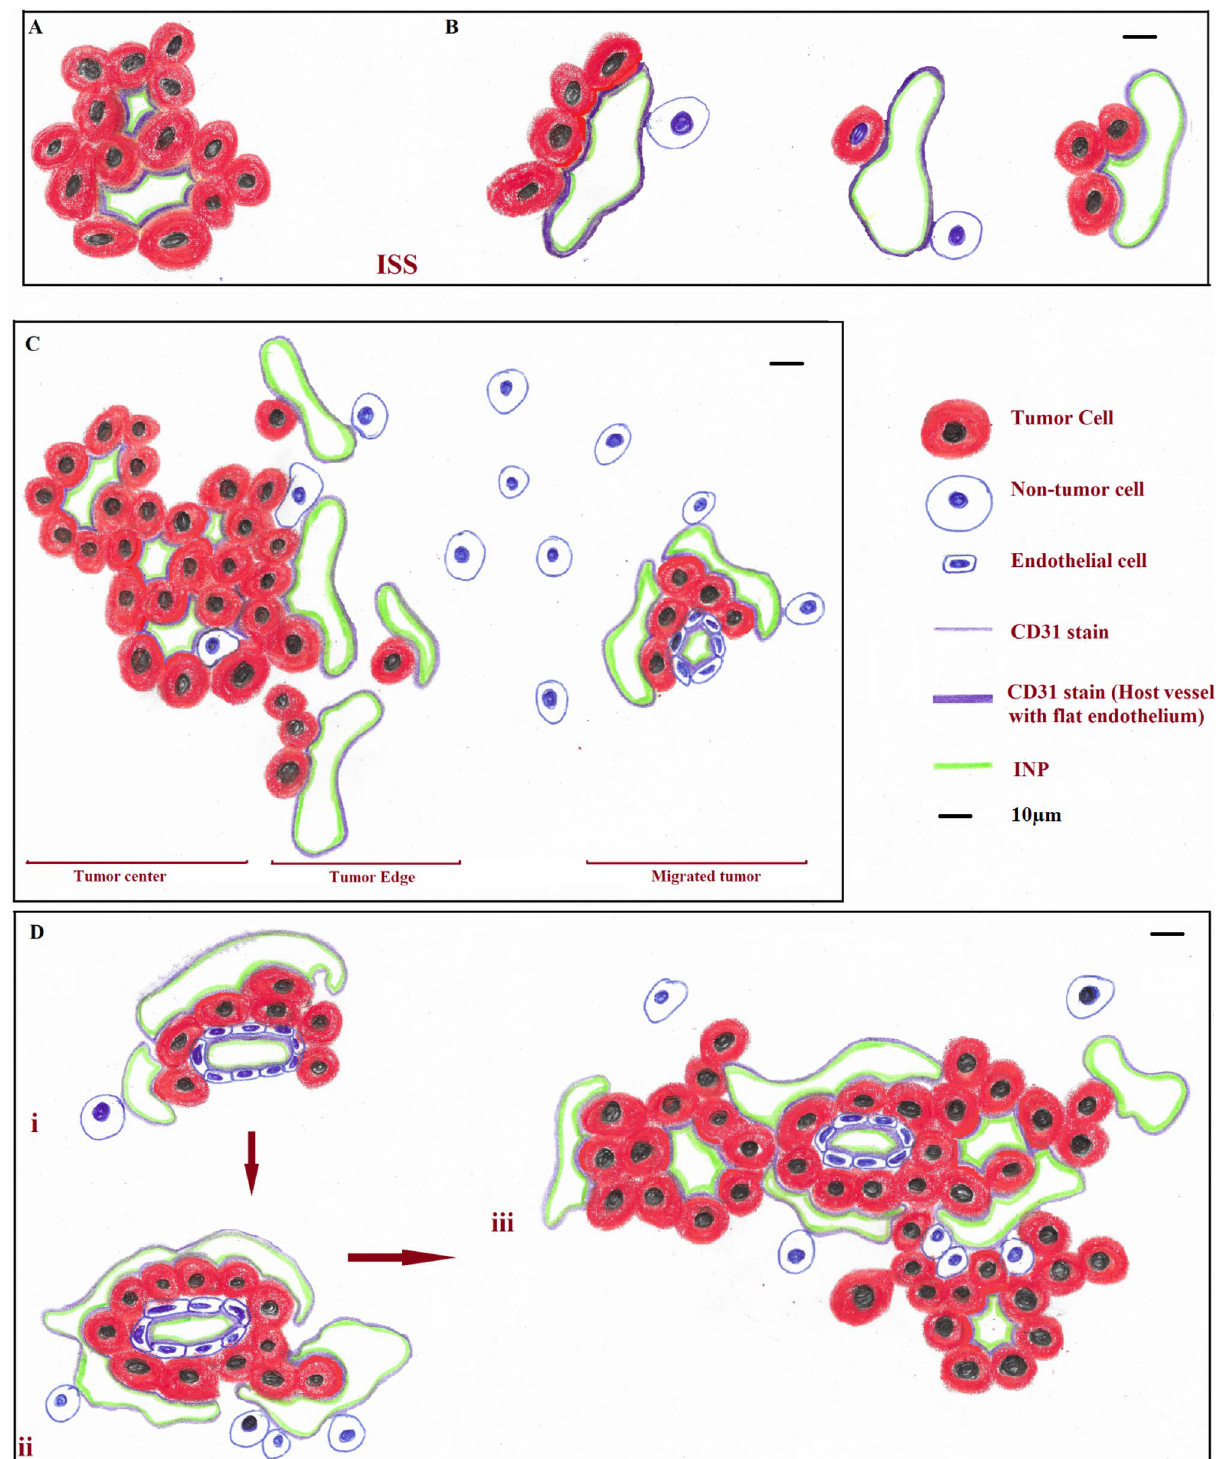
Figure 6. Diagrammatic summary of the relationships between MBD-MB-231 tumor cells, I-SS (vascular mimicry) and INP and CD31 labeling in the inner tumor, the tumor rim and tumor cells that have migrated along blood vessels. A . ISS bounded by tumor cells only; B . ISS bounded by tumor cells partially; C . ISS in the main tumor center, tumor edge and in at the migrated tumor; D . Proposed process of formation and maturation of ISS. INP and CD31 representations are intended to be